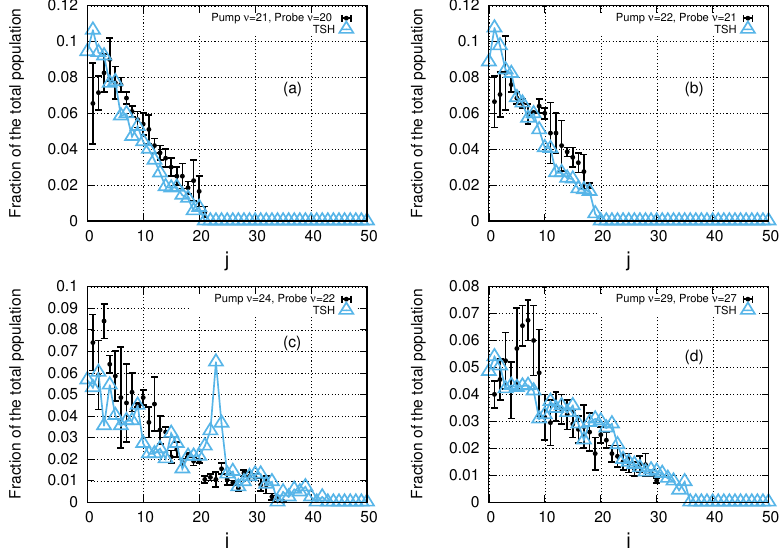
Figure 8. Rotational distribution for the transitions (a) v = 21–20, (b) v = 22–21, (c) v = 24–22 , (d) v = 29–27. Experimental results correspond to